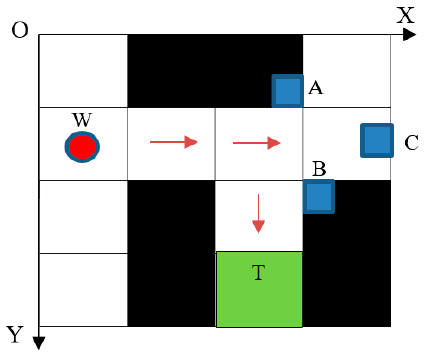
Figure 6. Coordinates of the wheelchair, landmarks, and target in simulated 2D grid map.